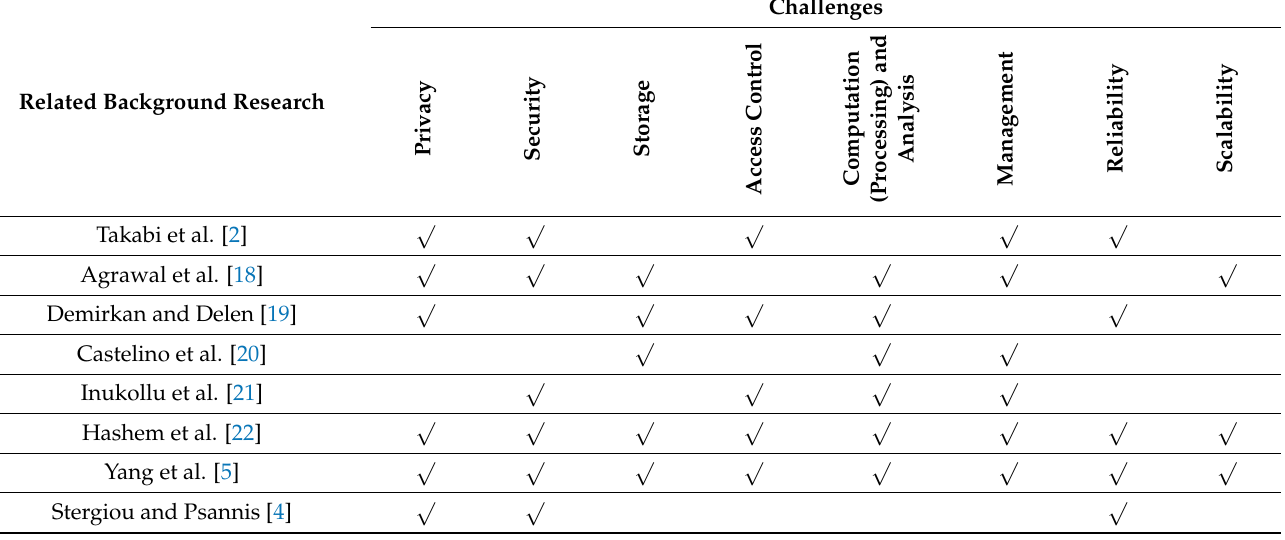
Table 1. Background research challenges in the field of the integrated models/methods of Cloud Computing technology and Big Data